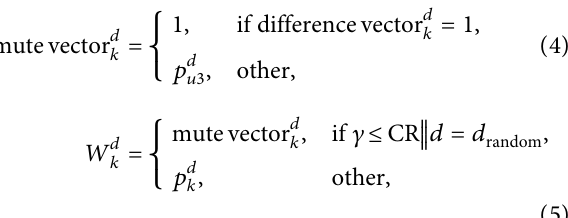
Figure 1: The proposed model for